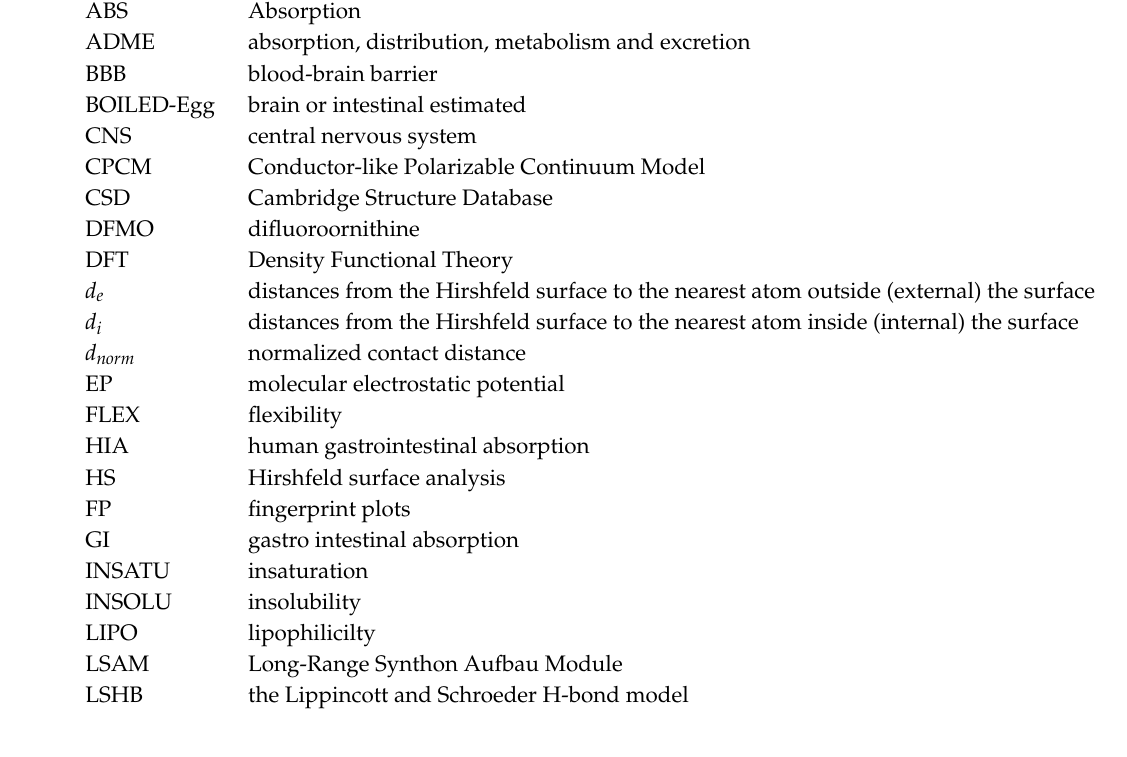
Table S8. Properties of ornithine moiety in analyzed structures, as derived from HS calculations. Table S9.